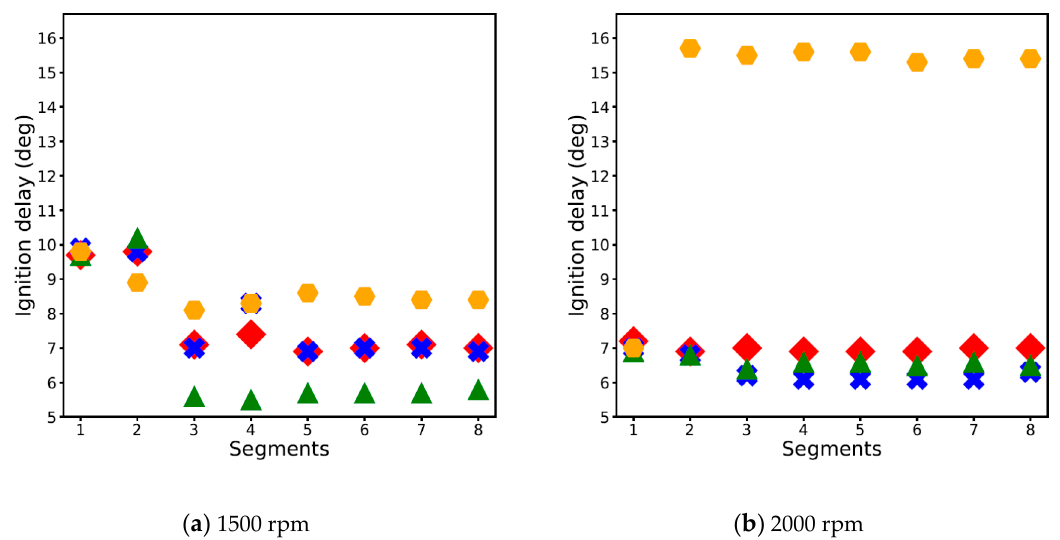
Figure 11. Ignition delay at all loads in each stage at ( a ) 1500 rpm and ( b ) 2000 rpm. The red thick diamond represents 100% load, the blue thick cross 50% load, the green triangle 75% load and the orange hexagon 25% load.